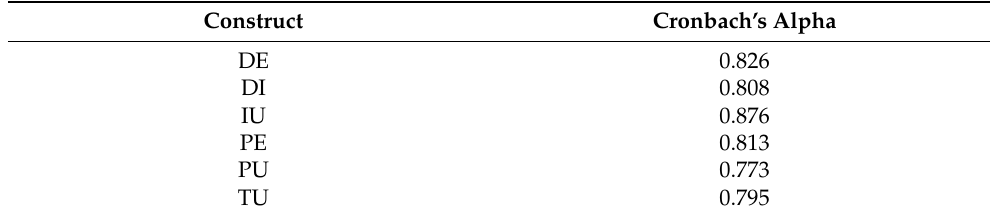
Table 3. Cronbach’s Alpha values for the pilot study (Cronbach’s Alpha ≥